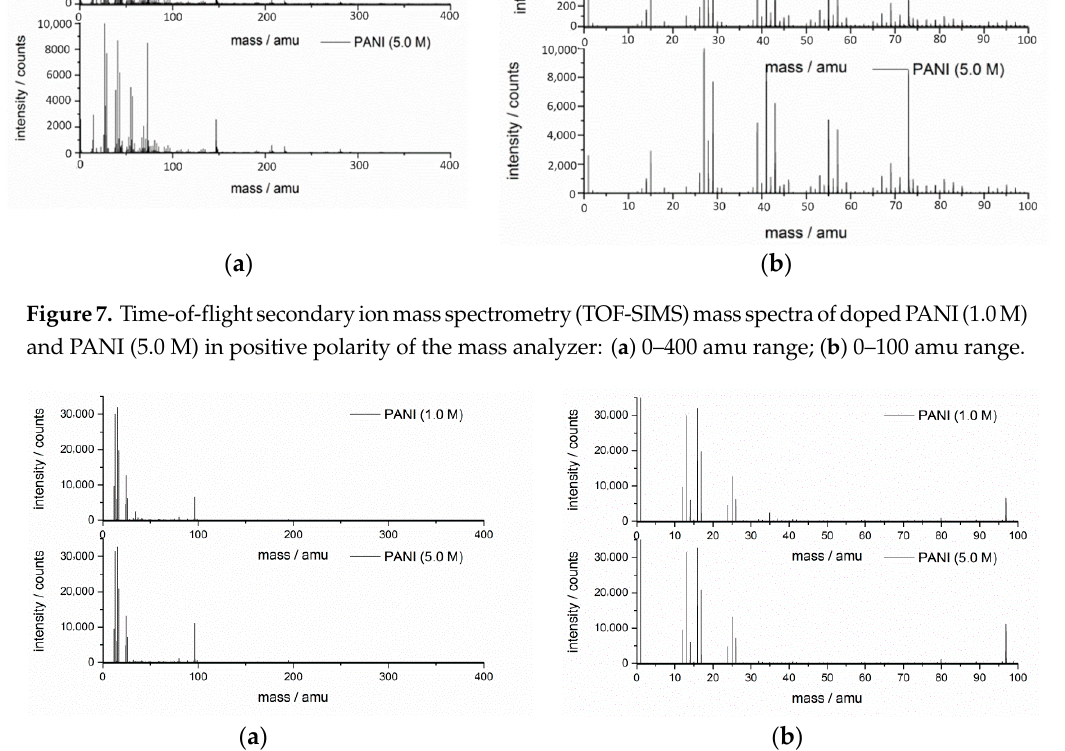
Figure 8. TOF-SIMS mass spectra of doped PANI (1.0 M) and PANI (5.0 M) in negative polarity of the mass analyzer: ( a ) 0–400 amu range; ( b ) 0–100 amu Table 3. Selected peaks and their assignment observed in positive- and negative-ion time-of-flight secondary ion mass spectrometry (TOF-SIMS) spectra of investigated samples.